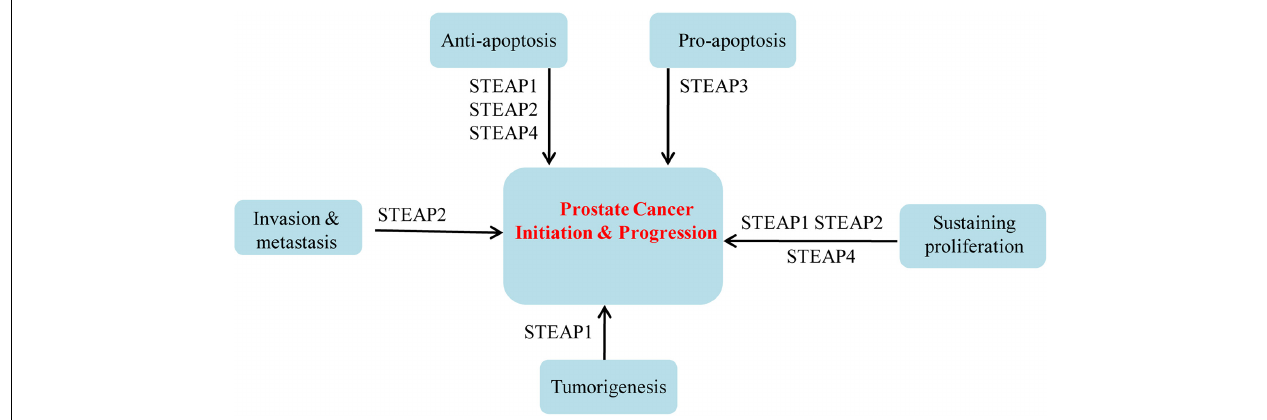
FIGURE 1 | Roles of STEAPs in prostate cancers.